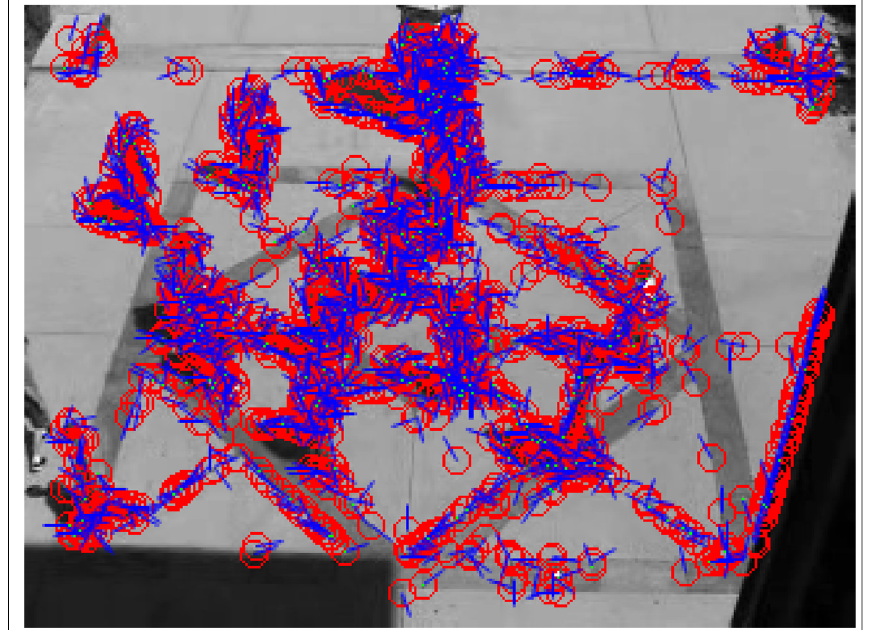
Figure 7. The results of interaction force features over a crowded scene.